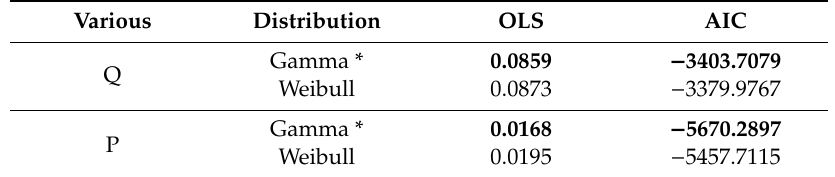
Table 5. Performance of parametric methods for fitting marginal distributions of various